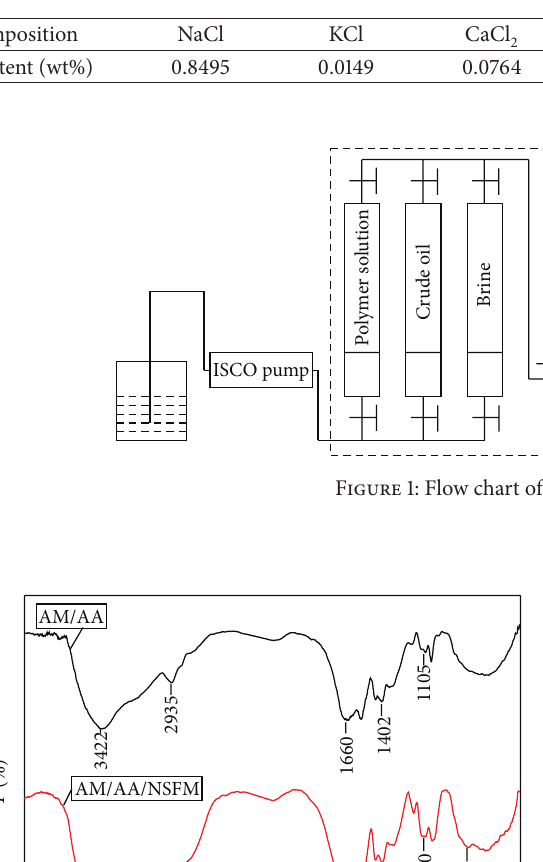
Table 1: Composition and TDS of brine.